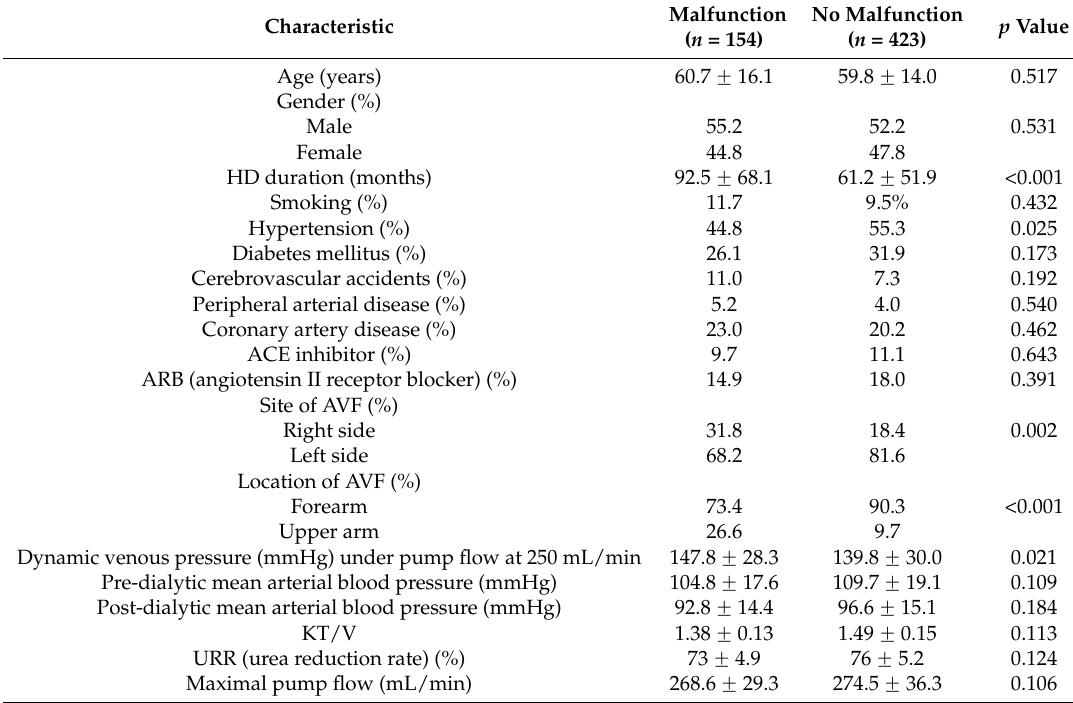
Table 1. Clinical characteristics of Hemodialysis (HD) patients by status of Arterio-venous fistula (AVF)